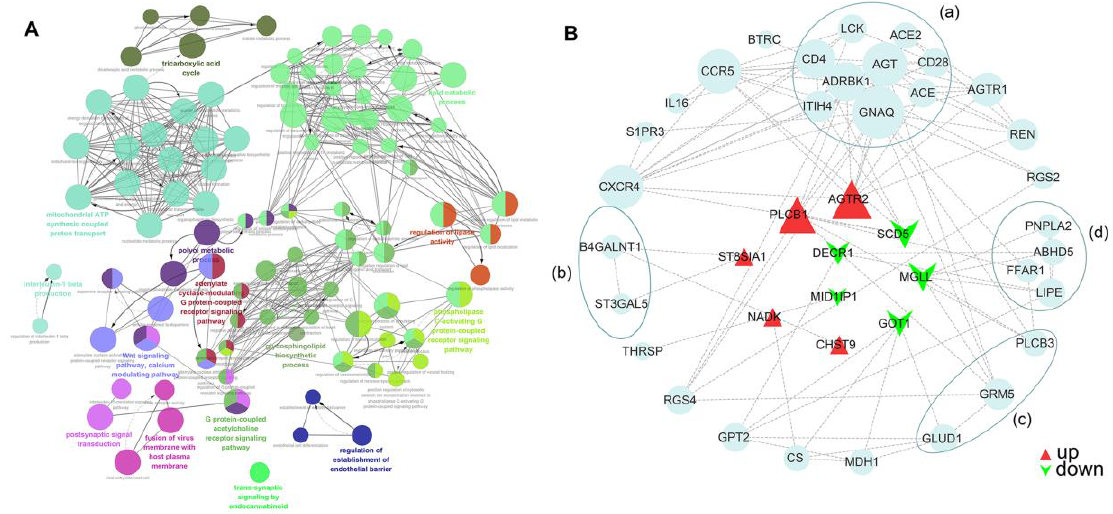
Figure 3. Biological function analysis of DEGs. ( A ) GO term network of DEGs. Each node stands for an enriched GO term (adjusted p value (Corrected with Bonferroni downgrading procedure)< 0.05). Nodes are interconnected when the gene overlap is >50% according to the kappa score; ( B ) protein–protein interaction (PPI) network. The four circle areas ( a – d ) were most significant cluster in MCODE analysis. DEGs, differentially expressed genes; GO, gene ontology; MCODE, molecular complex detection. More details are given in Tables S8 – S10.